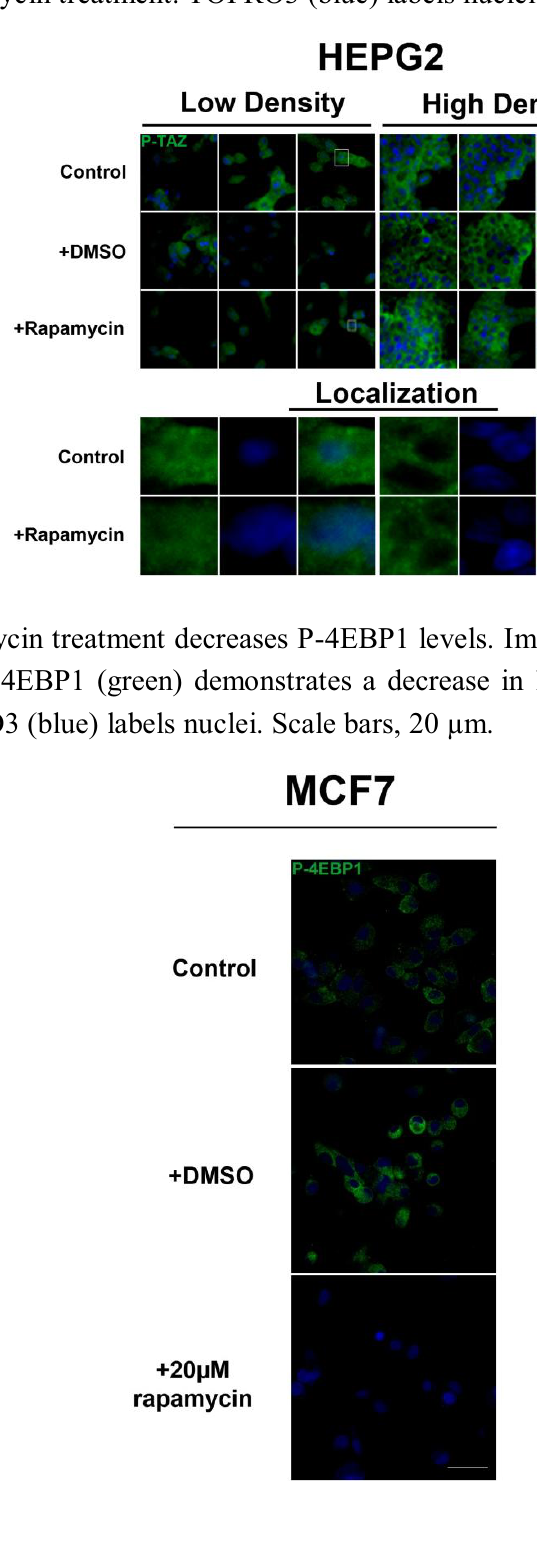
Figure S4. Rapamycin treatment does not affect P-TAZ expression or localization in HepG2 cells. Immunofluorescent staining of P-TAZ (green) in HepG2 cells with and without rapamycin treatment at low and high cell density conditions demonstrates no changes. Bottom panels represent box in top images: localization of P-TAZ at low cell density conditions demonstrates mostly nuclear localization that does not change upon rapamycin treatment, while in high density conditions, P-TAZ is cytoplasmic and does not change upon rapamycin treatment. TOPRO3 (blue) labels nuclei. Scale bars, 20 µm.